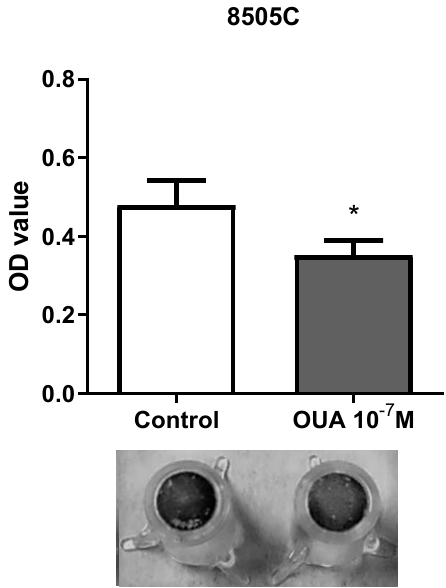
Figure 4. Ouabain decreased 8505C migration ability. 8505C cells were cultured in the absence or presence of 10 − 7 M of ouabain for 24 h and then allowed to migrate through transwell inserts for 24 h, as described in Materials and Methods section. Bar graph displays transwell migration measurement as mean OD ± SEM of four independent experiments performed in duplicate. A representative image of transwell inserts with 8505C control and ouabain-treated migrating cells stained with crystal violet is also shown. * p < 0.05 using paired t -test.